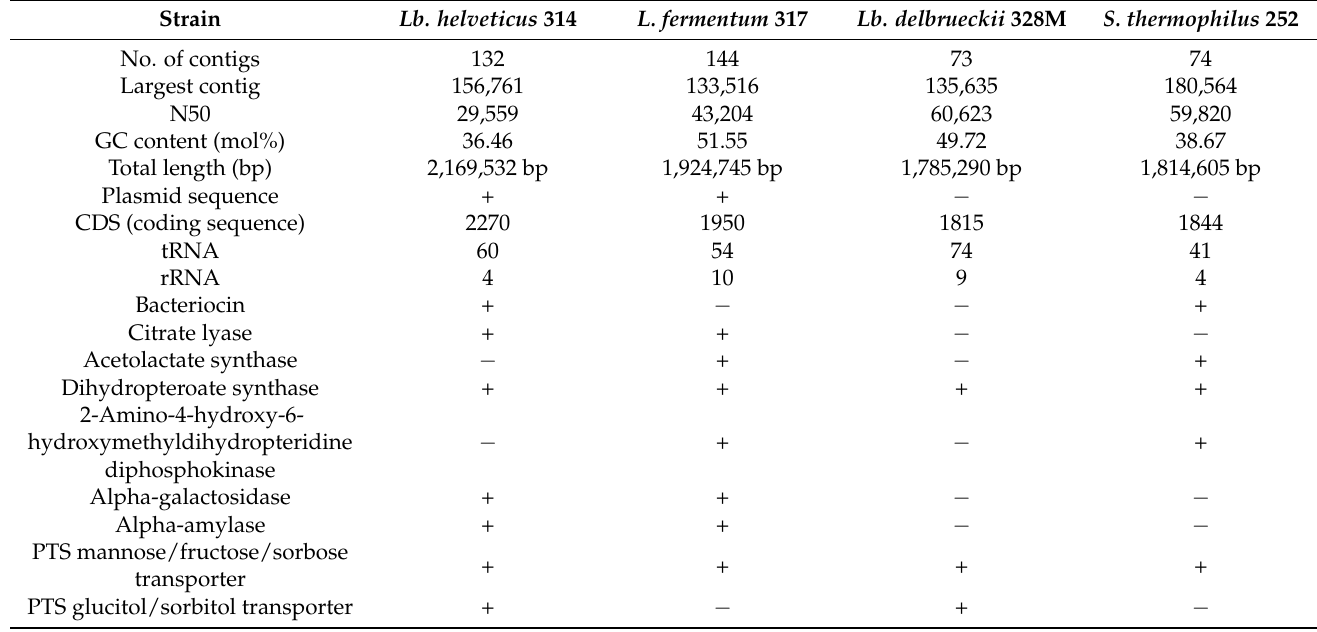
Table 1. Results of genome sequencing of representative predominant strains of nono production. The genome sequence data for L. fermentum 317 and Lb. delbrueckii 328M were obtained previous study [23]. +; detected, − ; not detected